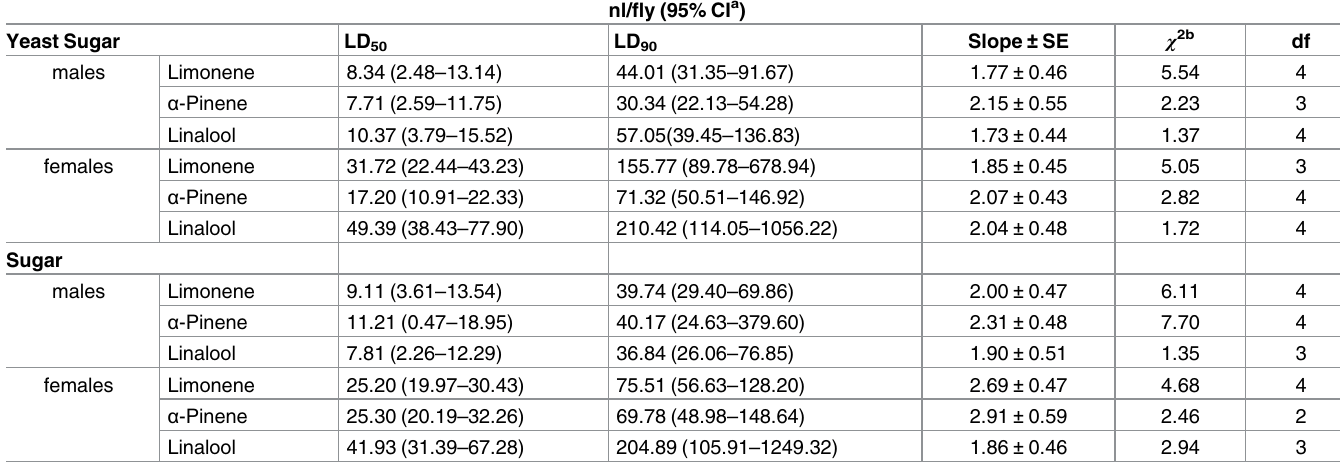
Table 1. LD 50 and LD 90 values for three monoterpenes (limonene, α -pinene and linalool) topically applied to male and female medflies fed with yeast and sugar (YS) or with sugar only